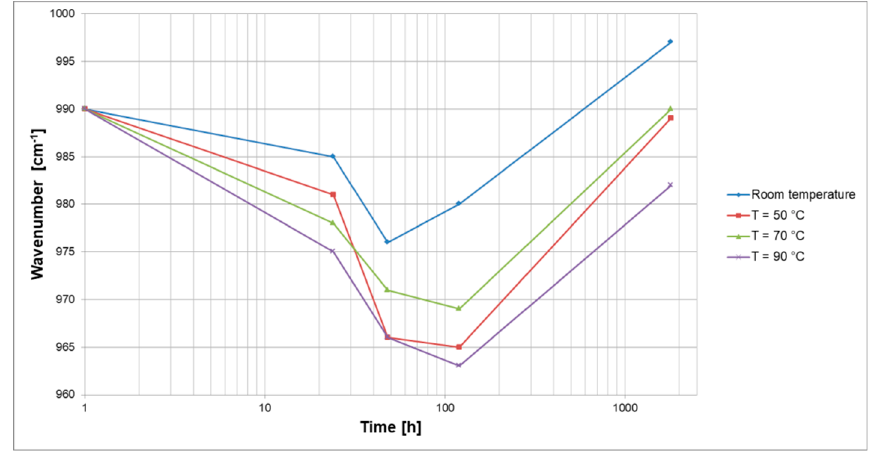
Figure 7. Si-O-T (T = Si or Al) band shifts of activated slag pastes A/R: 1/1 cured at different temperatures.